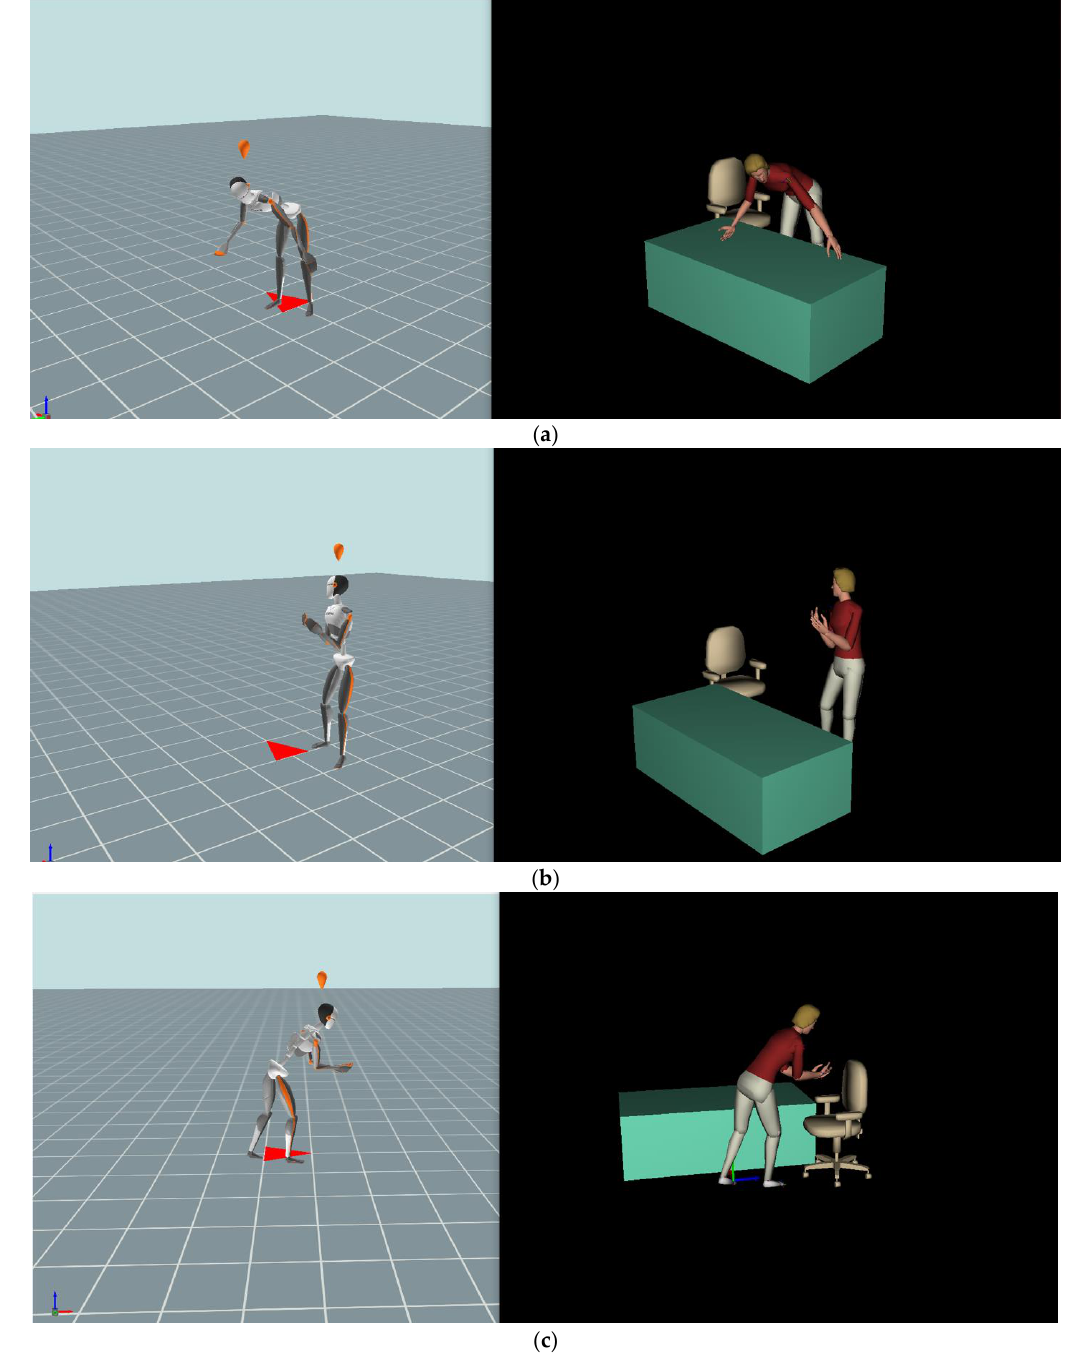
Figure 3. Three poses for the force analysis exposed on the lower back. The DHM_Xsens on the left represents the recorded actual human movement. The DHM_JACK on the right is driven by